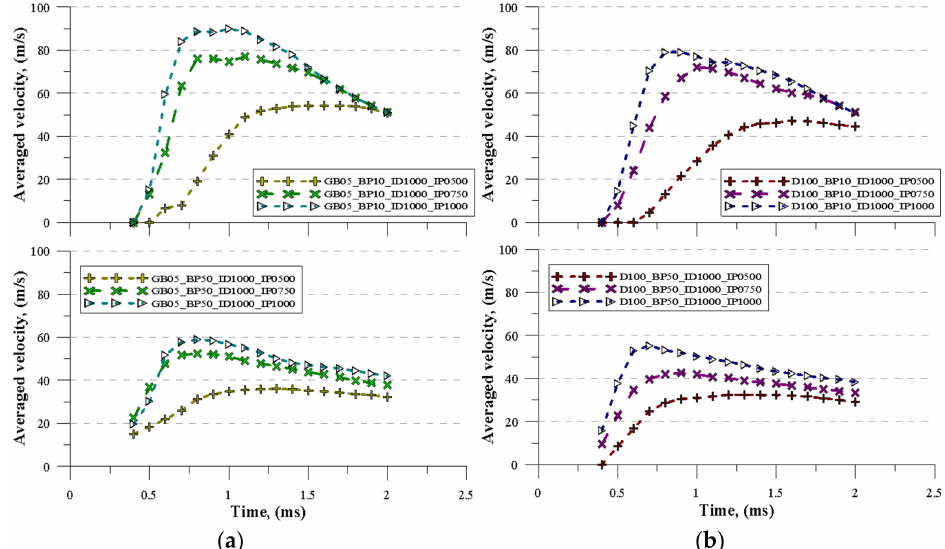
Figure 9. Average velocity of spray penetration of ( a ) GB05, and ( b ) D100 with an injection duration 1000 µ s at back pressures of 10 and 50 bar and injection pressures of 500, 750 and 1000